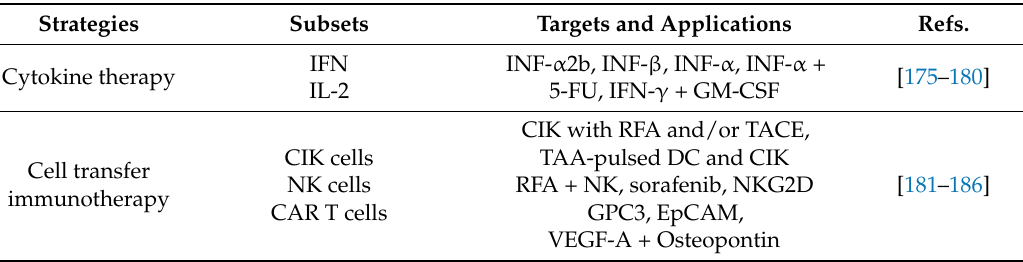
Table 1. Potentiality of immunotherapy against